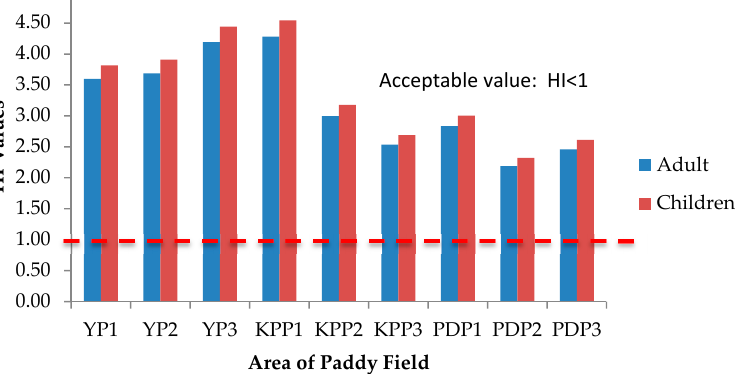
0.000.501.001.502.002.503.00